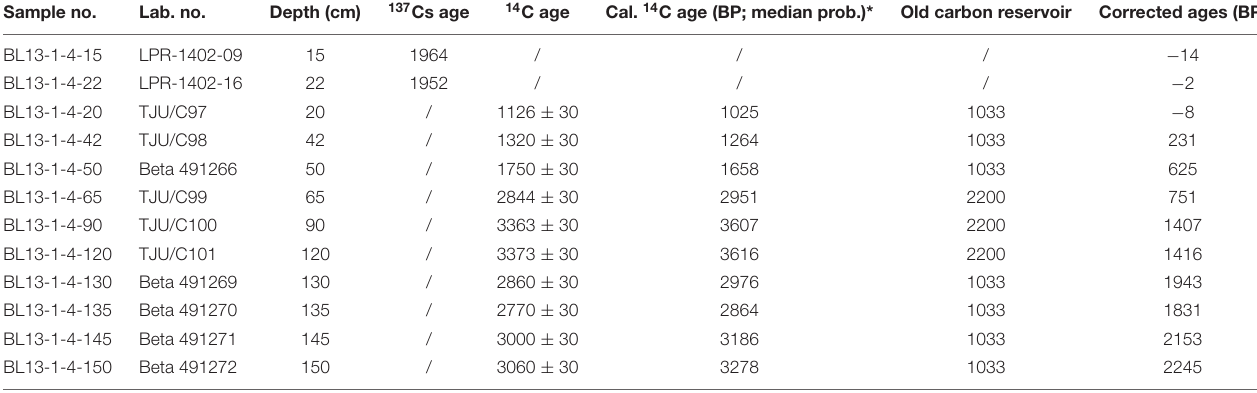
TABLE 2 | 14 C ages of sediment samples of core BL13-1-4 in Lake Bosten. Sample no.